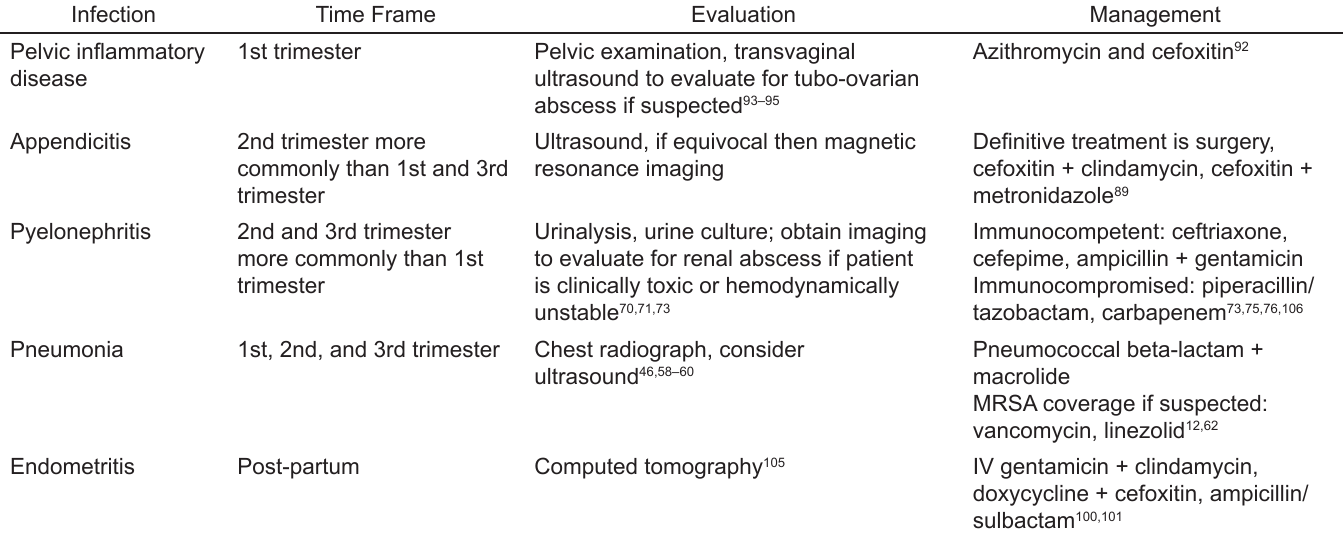
Table 4. Chronologic presentation of sepsis etiologies and recommended